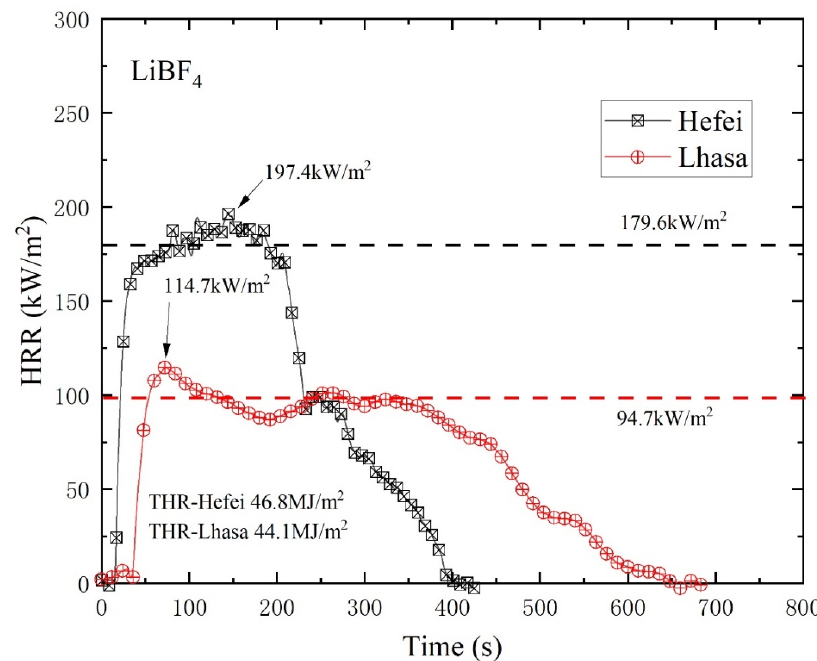
Figure 10. Heat release rate (HRR) curves of electrolyte with LiBF 4 in Hefei (black) and Lhasa (red). Energies 2020 , 13 , x FOR PEER REVIEW